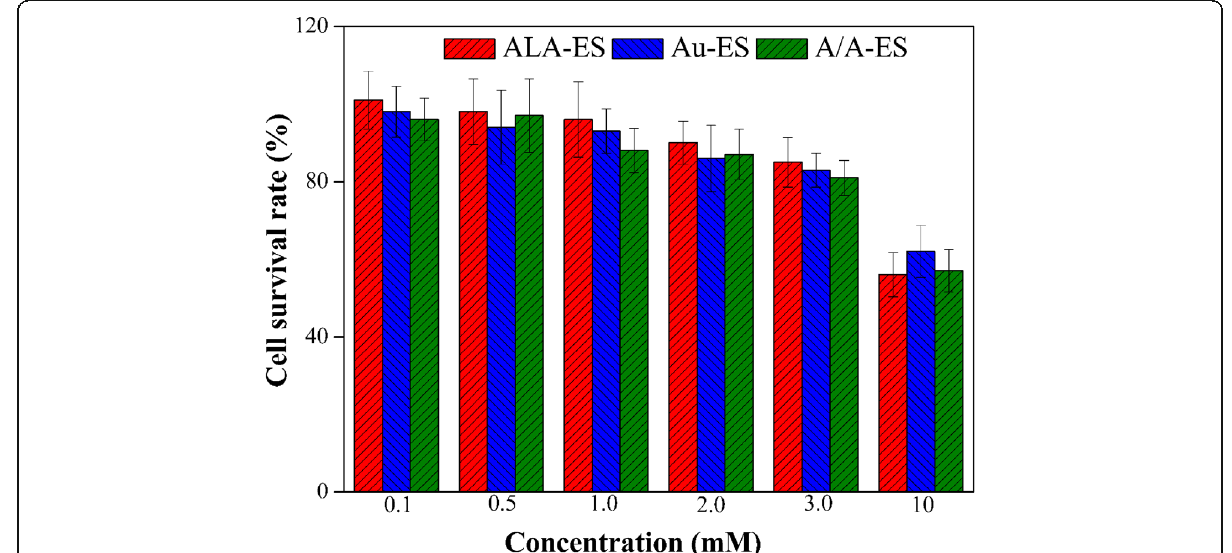
Fig. 3 The cell viability of HSF upon treatment with ALA-ES, Au-ES and A/A-ES in the dark for 12